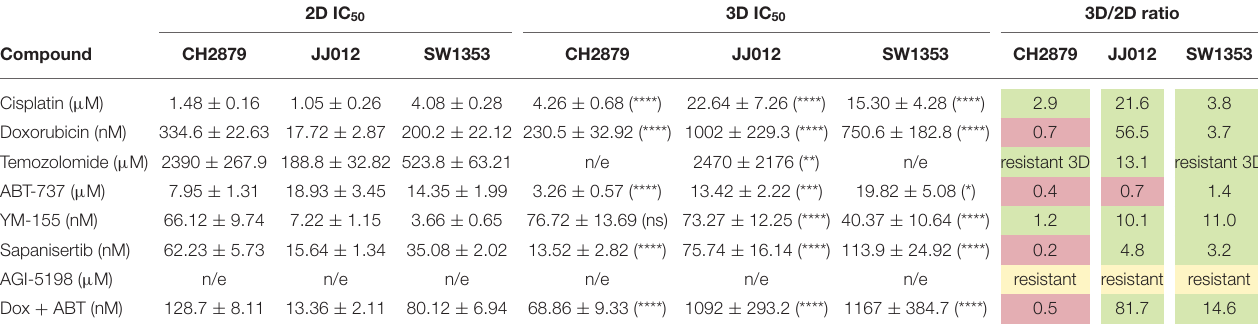
TABLE 1 | IC 50 values for 2D and 3D cultured chondrosarcoma cell lines treated with a small panel of